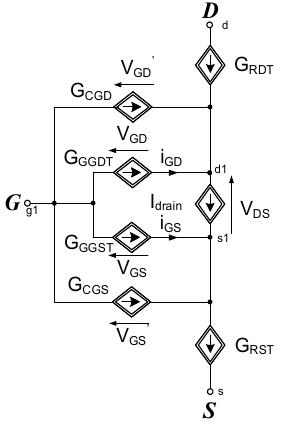
Figure 6. Network form of the modified model of the JFET.